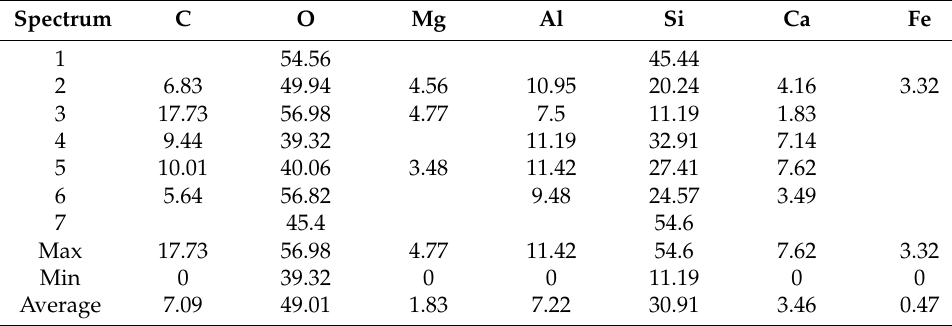
Table 3. Element mass percentage content of the carbonation layer in group AI (wt%).